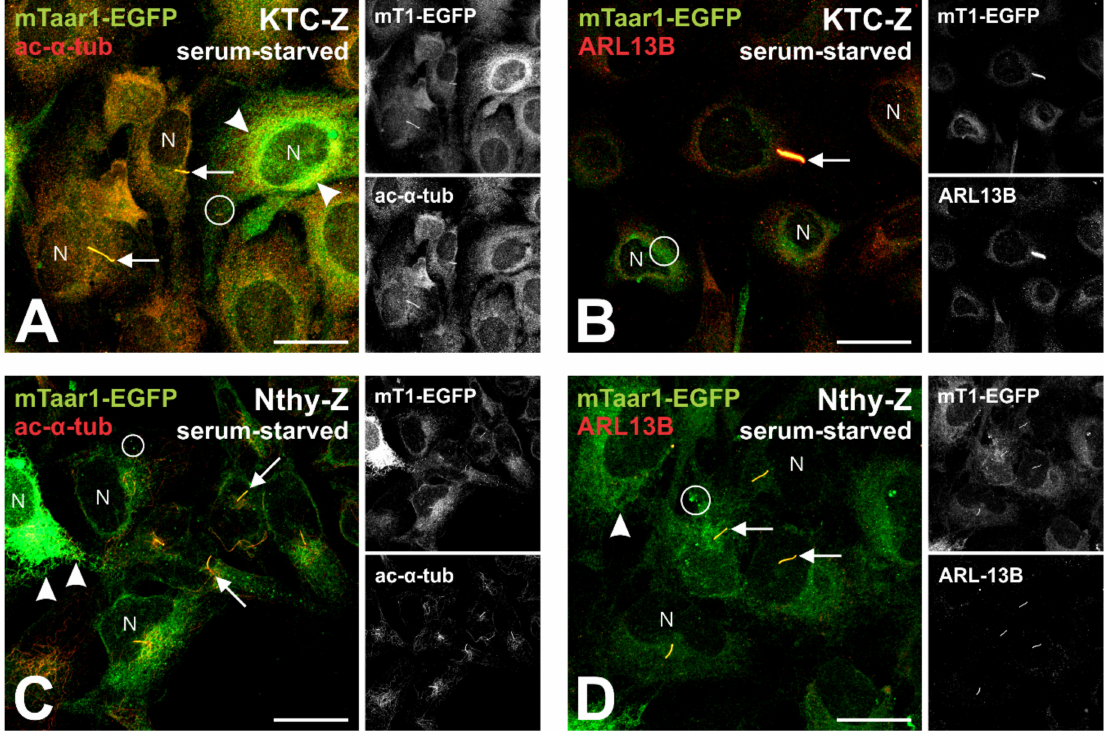
Figure 7. Ciliogenesis and co-localization of mTaar1-EGFP with cilia markers in KTC-Z and Nthy-Z cells. ( A – D ) KTC-Z and Nthy-Z cells serum-starved for 48 h ( A , B and C , D , respectively) were fixed and immunostained with antibodies against the axonemal cilia markers acetylated alpha-tubulin ( A , C , red) or ARL-13B ( B , D red), respectively. The formation of long-extended, acetylated alpha-tubulin- or ARL13B-positive structures (red) emanating from next to or above the nuclei (N) indicates ciliogenesis in the transduced cells arrested at the G 1 /S transition of the cell cycle (arrows). Co-localization with the fluorescence of mTaar1-EGFP (green) indicates the chimeric protein to localize to the compartments of the secretory pathway (arrowheads and circles) and to reach primary cilia of transduced cells (yellow, arrows), indicating targeting and transport of mTaar1-EGFP to cilia of KTC-Z and Nthy-Z cells. Merged ( A – D , left panels) and corresponding single channel fluorescence micrographs of xy-scans ( A – D , right panels, top to bottom: mTaar1-EGFP and acetylated alpha-tubulin in A and C , or ARL13B in B and D ) are provided as indicated. Arrows point to ciliary extensions, arrowheads to ER or Golgi apparatus, and circles highlight puncta, which may represent ER-Golgi intermediate compartments or ER-exit sites. Scale bars represent 20 µ